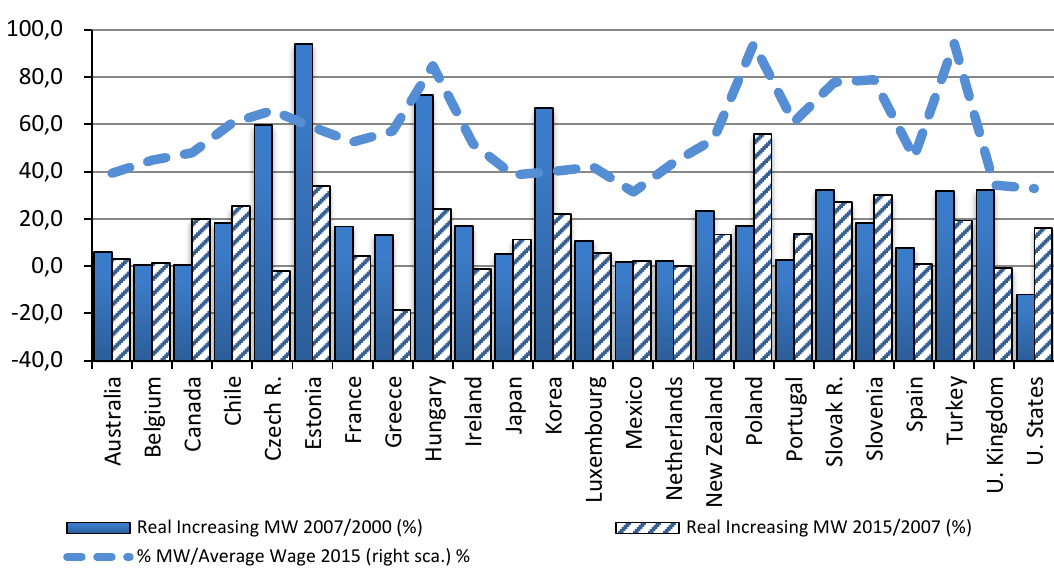
Figure 2. Minimum wages in OCDE countries. Source: own elaboration from Neumark & Wascher (2003), OECD (2004) and